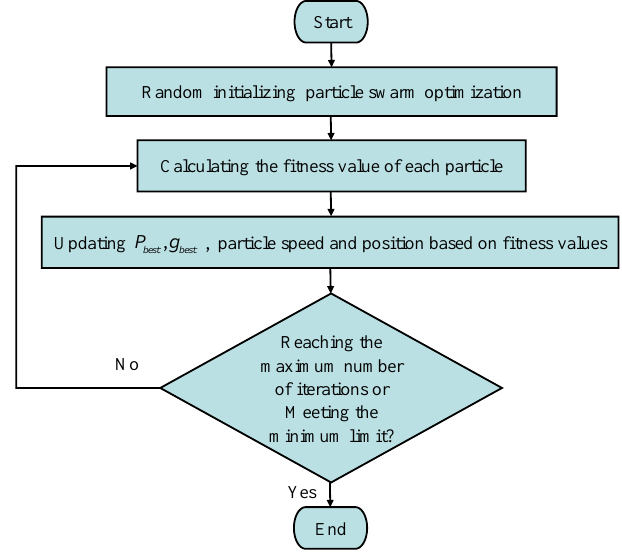
constant. Figure 3 is a flow chart of the steps of the particle swarm algorithm.